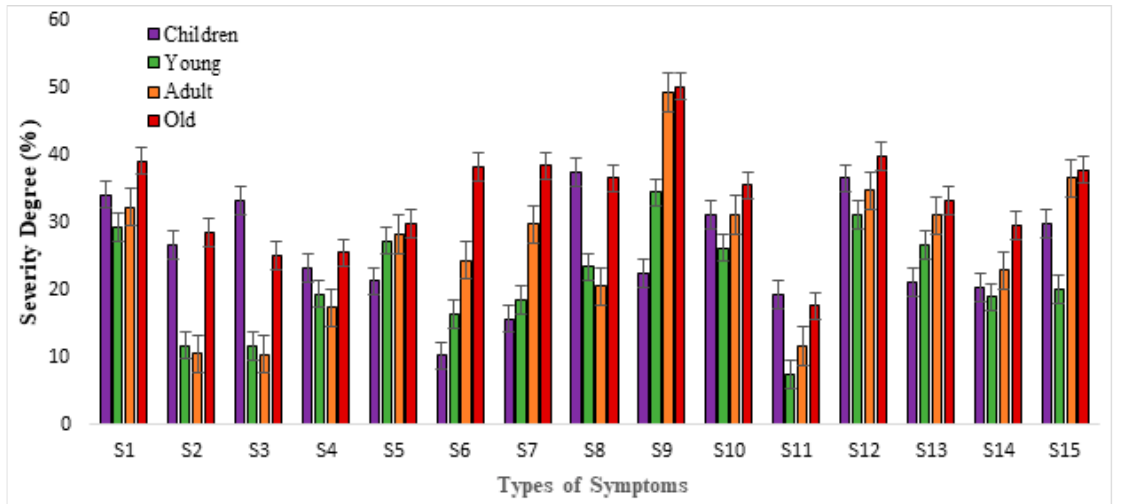
Figure 4. The severity of different health symptoms for different age groups. Note: S 1 : dry